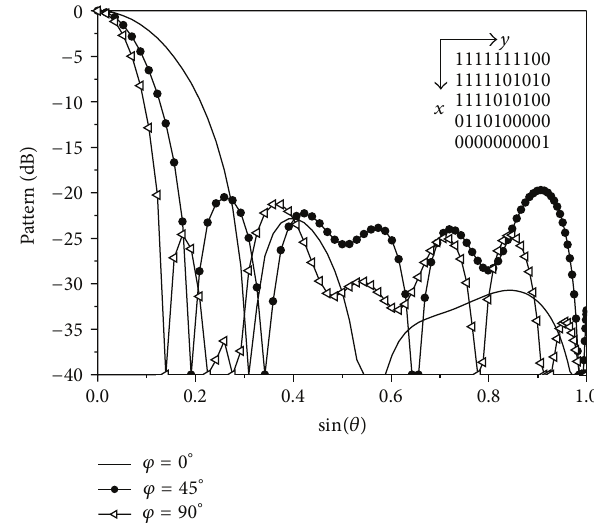
Figure 5: Radiation patterns in 𝜑 = 0 ∘ , 𝜑 = 45 ∘ , and 𝜑 = 90 ∘